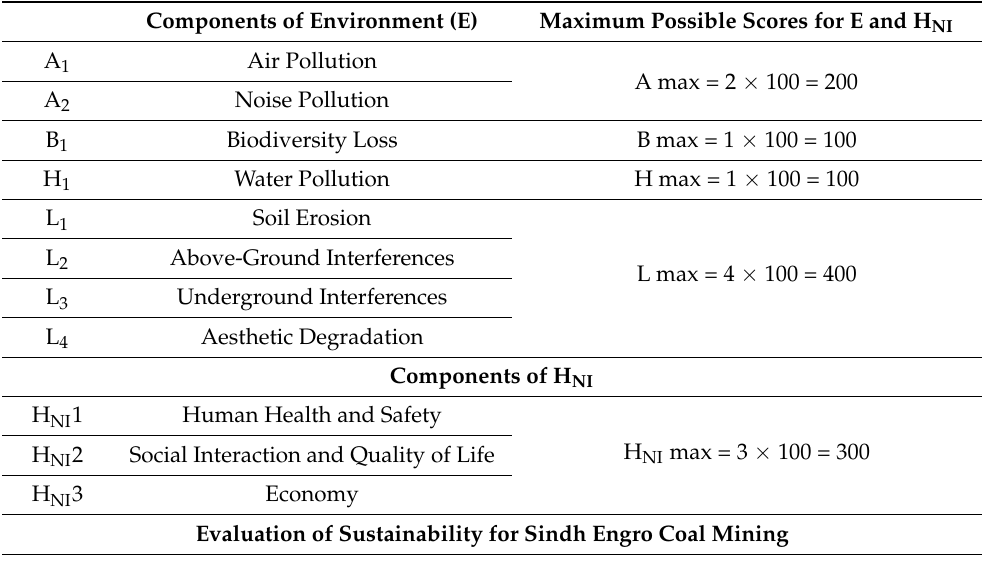
Table 5. Determination of sustainability (S)